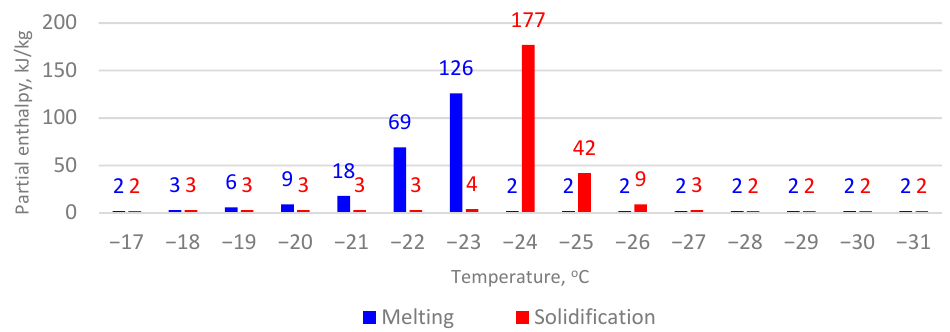
Figure 2. Distribution of the partial enthalpy of the SP-24 phase change material applied. Adapted from [20]. Table 1. Physical properties of the applied Rubiterm SP-24 phase change material. Adapted from [20].